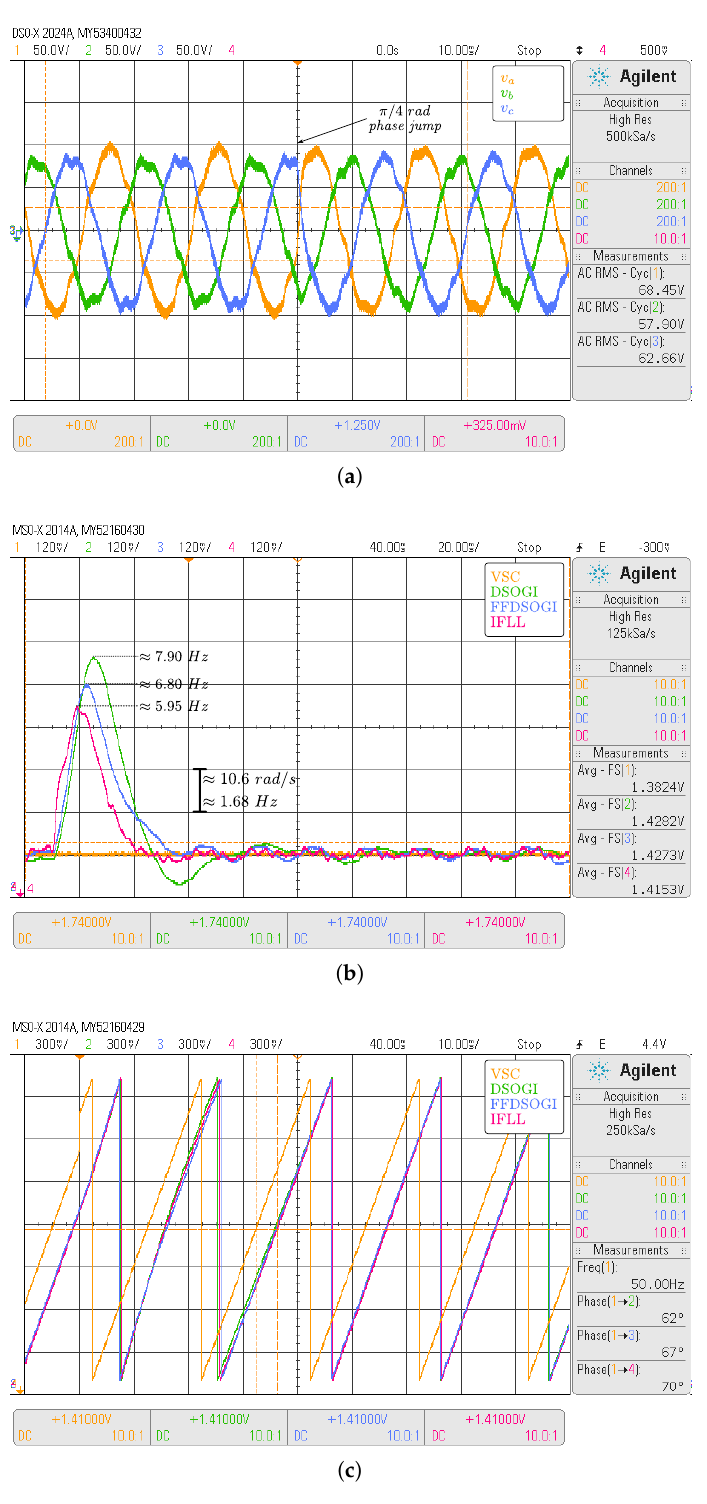
Figure 20. Experimental results for test #2 phase jump. ( a ) Measured voltages, ( b ) estimated frequency, and ( c ) estimated phase